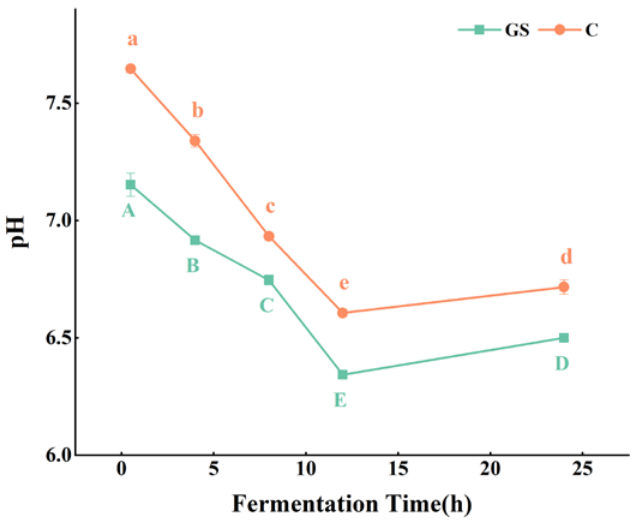
Figure 8. Change of pH during in vitro fermentation. Means with different letters in figures were significantly different at p < 0.05.